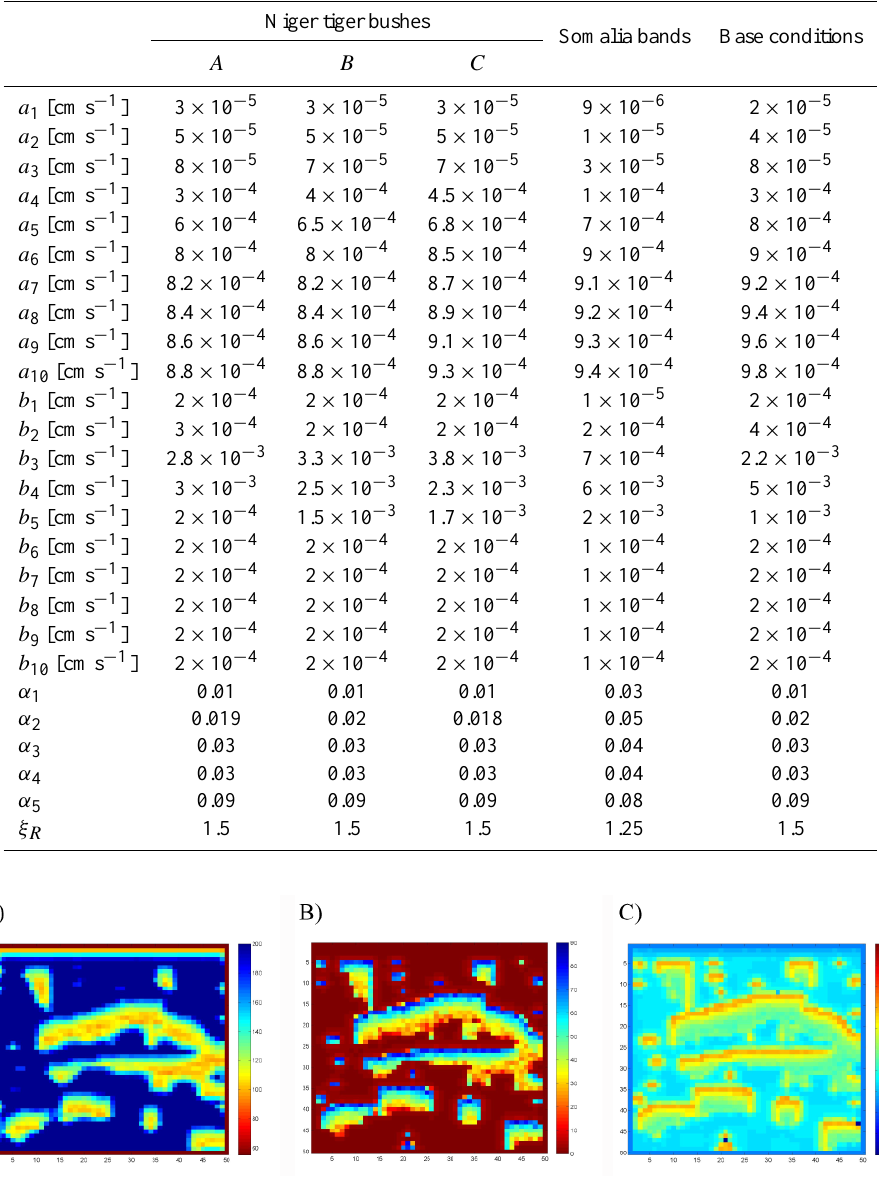
Table 2. Model parameters.